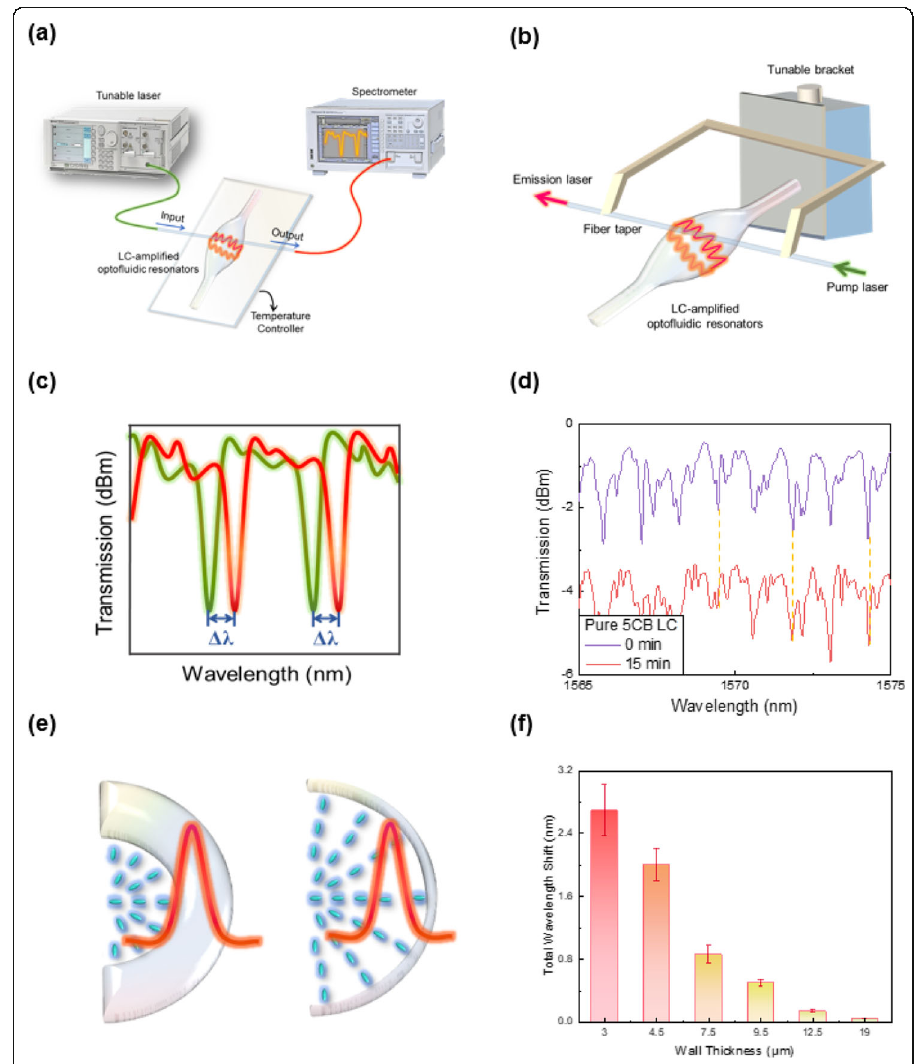
Fig. 2 Schematic of the ( a ) experimental platform and ( b ) fiber taper-coupled micro-resonator (coupling position is controlled by tunable bracket). The light from a tunable laser was coupled into the LC-amplified optofluidic resonator through the fiber taper to acquire the WGM spectrum and was further received in spectrometer. The addition of protein molecules led to the orientation transition of LC and ( c ) the wavelength shift of WGM spectrum. ( d ) WGM laser spectral responses of LC-amplified optofluidic resonator under a controlled experiment (0g/ml BSA) at 0min (purple curve) and 15mins (red curve), respectively. In addition, effect of the wall thickness on spectral responses was studied. ( e ) Illustration of intensity distribution of the incident laser beam for thick (left) and thin (right) wall of the microcavity. ( f ) WGM spectral responses of LC- amplified optofluidic resonator with various wall thicknesses at 1mg/ml BSA within